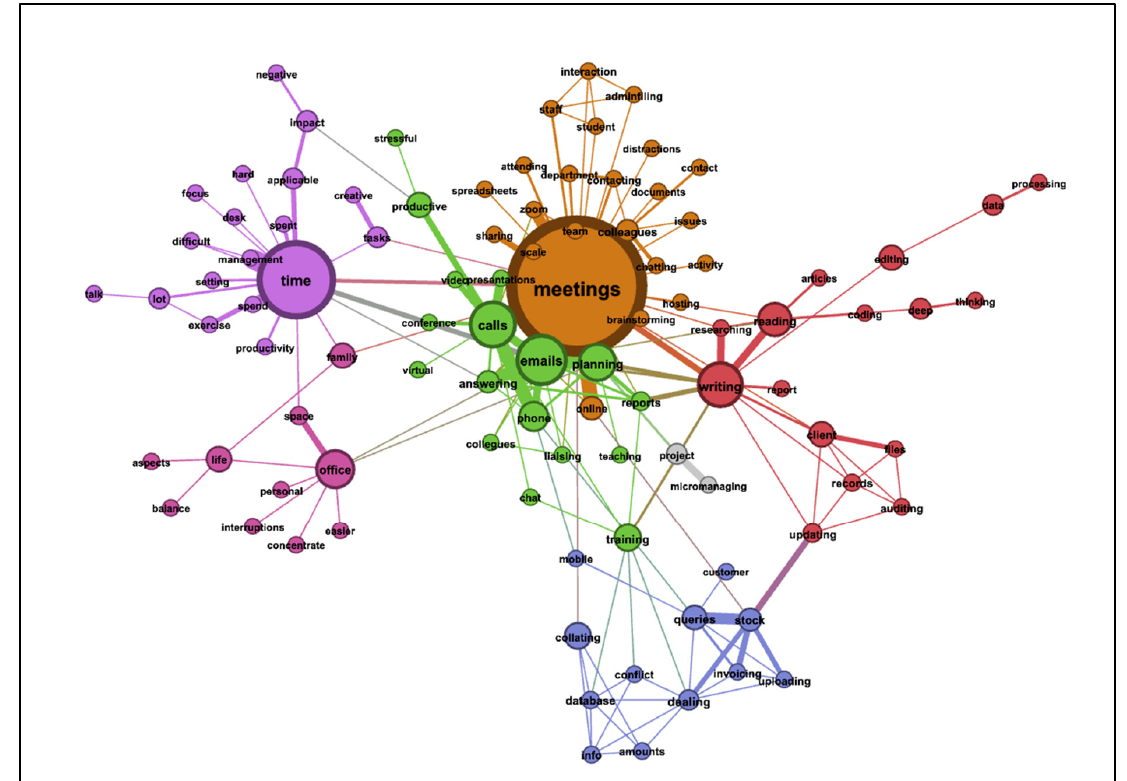
Figure 3. United Kingdom Semantic Network.